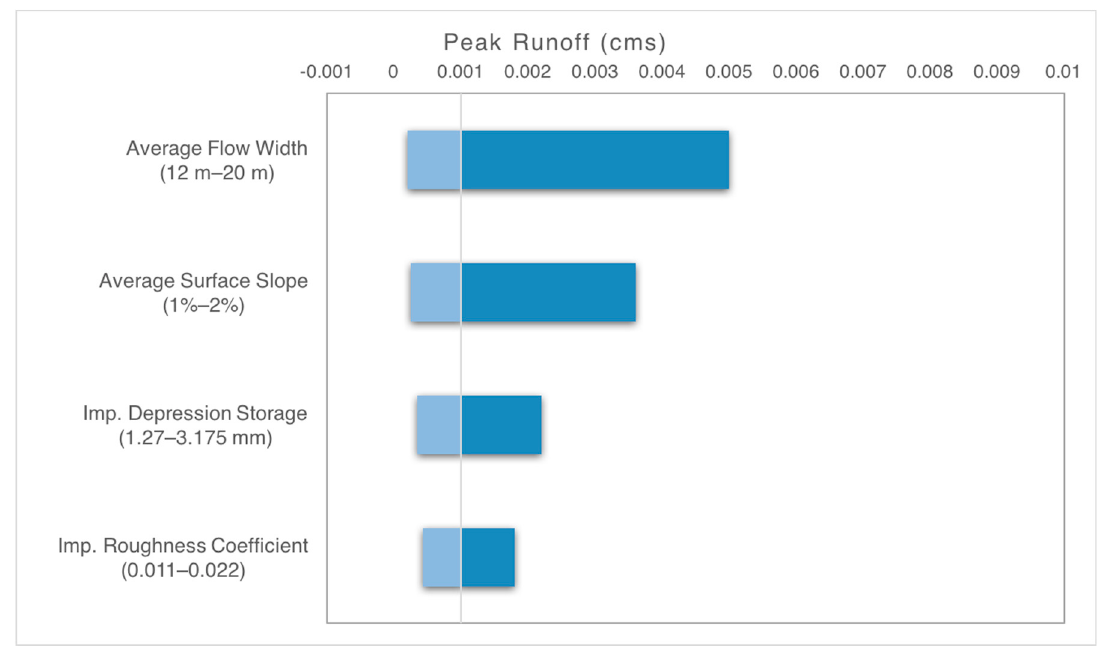
Figure 6. Sensitivity analysis tornado plot of model parameters and their effect on peak runoff rate.